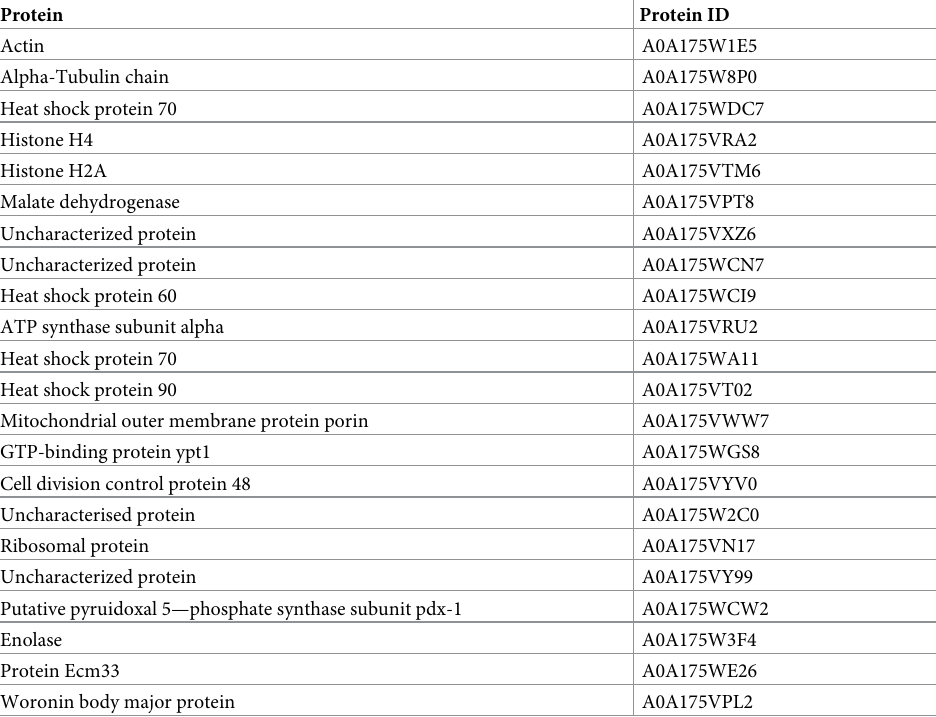
Table 1. 22 M . mycetomatis proteins found in grain on all time